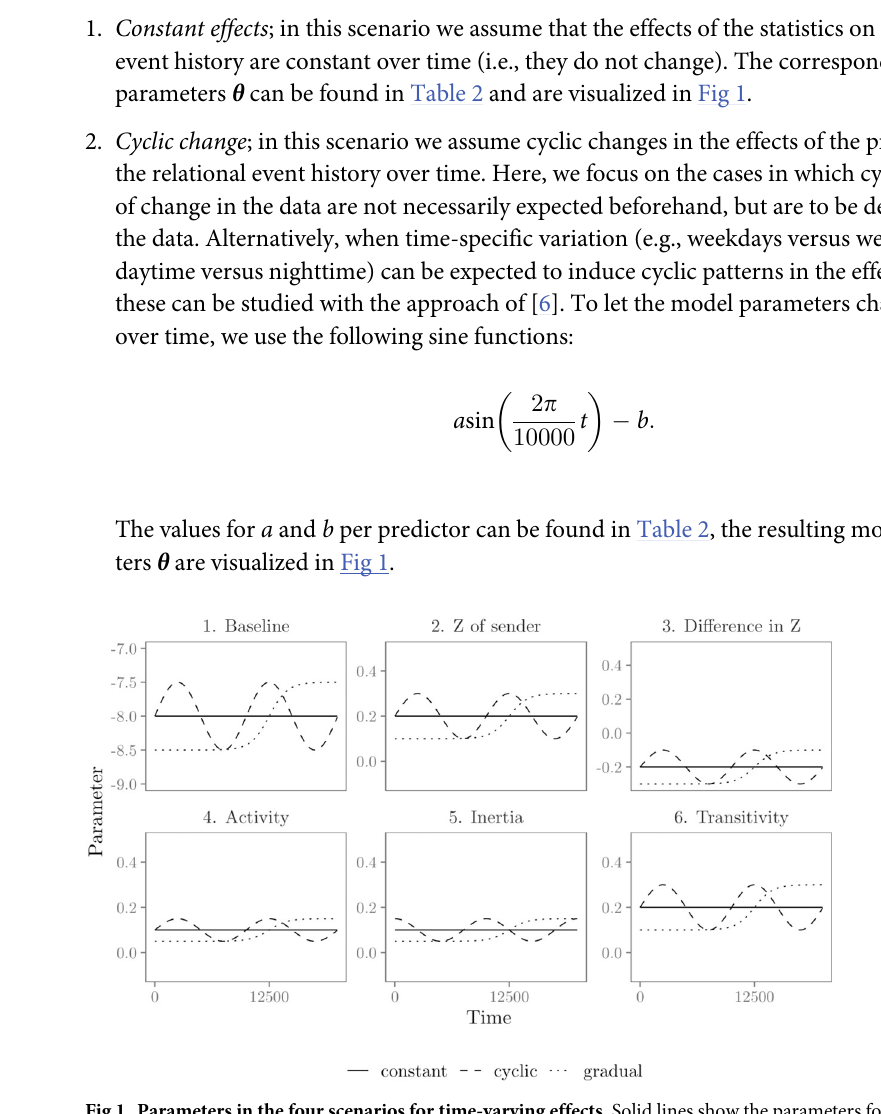
Fig 1. Parameters in the four scenarios for time-varying effects. Solid lines show the parameters for the constant effects in the ‘constant’ and ‘mixed’ effects scenarios, dashed lines show the parameters for the cyclically changing effects in the ‘cyclic’ and ‘mixed’ effects scenarios, and dotted lines show the parameters for the gradually changing effects in the ‘gradual’ and ‘mixed’ effects scenarios.